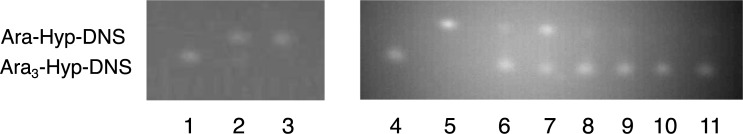
TLC analysis of the activities of deletion constructs and site-directed mutants towards Ara3-Hyp-DNS.The reaction was performed in a solution containing 50 μM Ara3-Hyp-DNS (substrate) and 50 mM Na-acetate buffer (pH 5.5). After development, the fluorescence of the dansyl group was detected. (Left) The substrate was incubated either without (lane 1) or with the deletion constructs (lanes 2 and 3, 0.45 mg/ml protein) at 30°C for 20 min. Lane 2, CΔ1049; lane 3, CΔ789. (Right) The substrate was incubated either without (lane 4), with CΔ1049 (lane 5, 2.5 mg/ml protein), or with site-directed point mutants of CΔ1049 (lanes 6–11, 2.5 mg/ml protein) at 37°C for 1 h. Lane 6, D515A; lane 7, D515N; lane 8, E713A; lane 9, E713Q; lane 10, E383A; lane 11, E383Q.